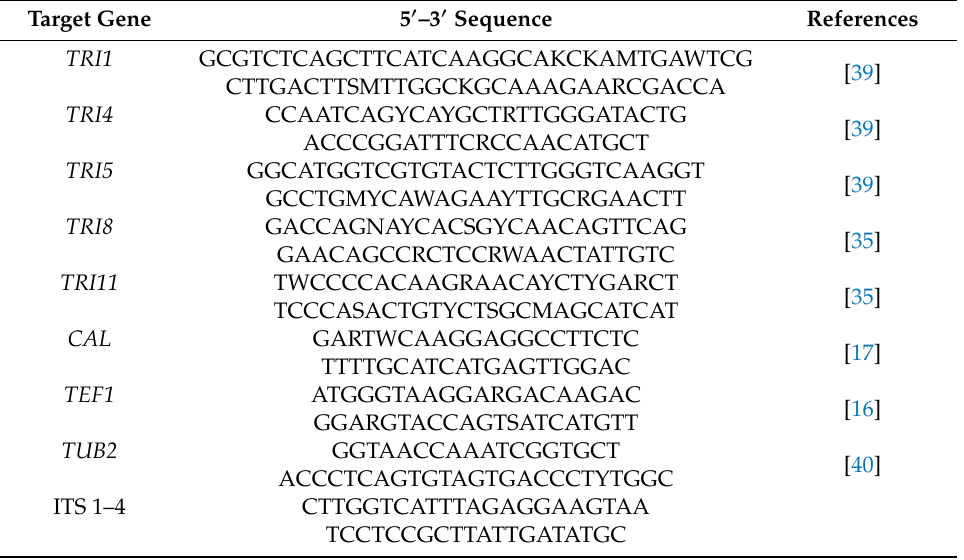
Table 1. Primers used in this study for DNA sequence amplifications. Target